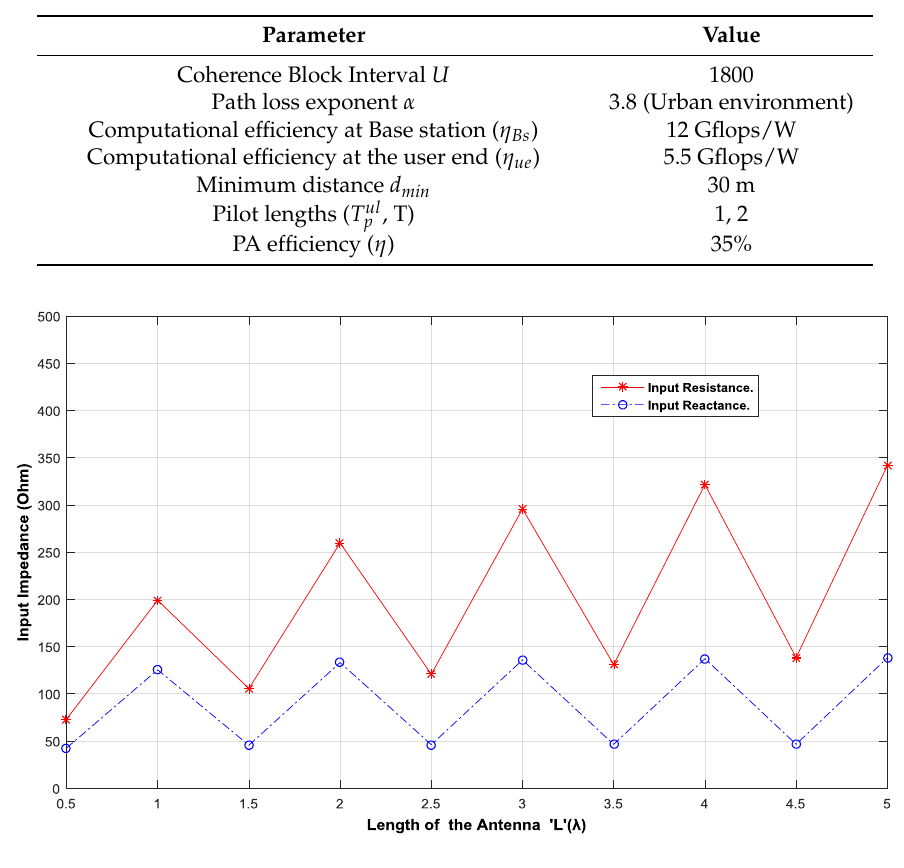
Table 3. Simulation Parameters.